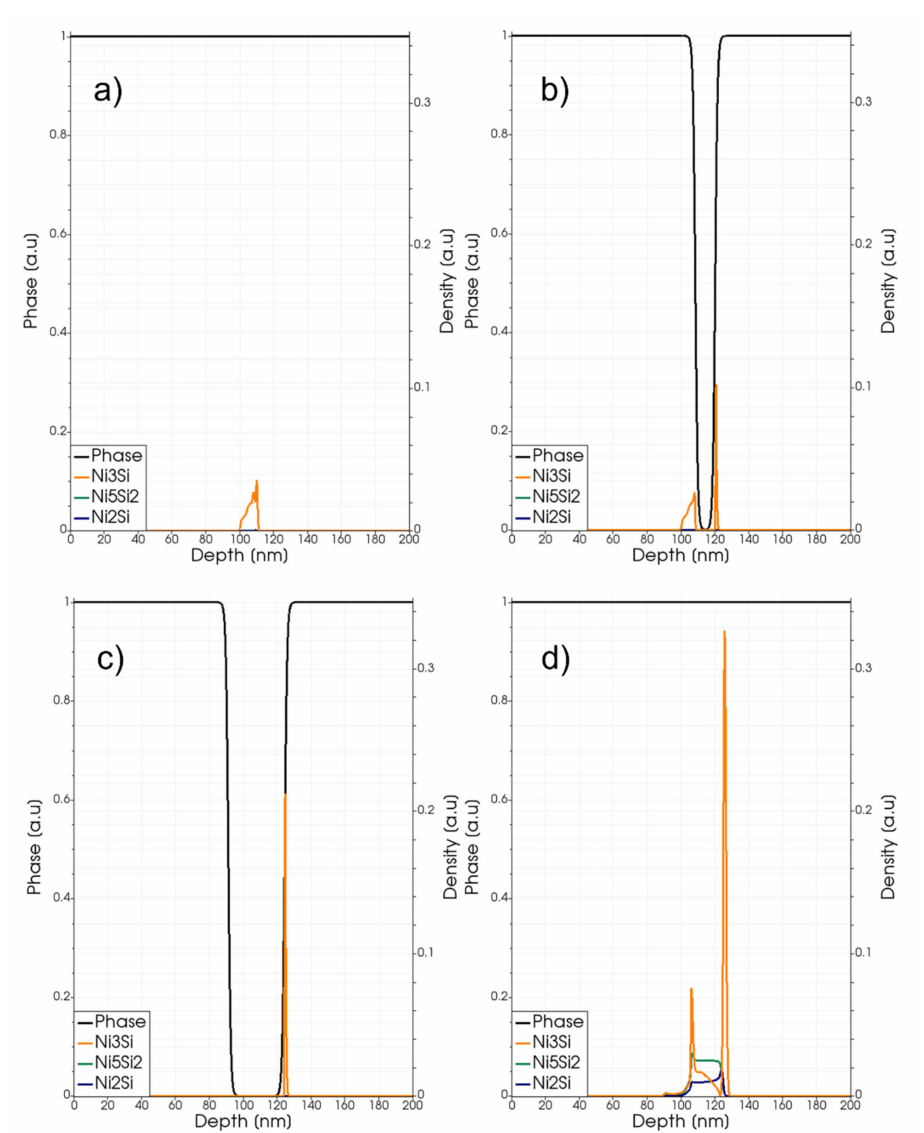
Figure 5. Phase-field (black line and left axis) and simulated local density (right axis scale) of the Ni 3 Si (dark yellow lines), Ni 5 Si 2 class (dark green lines) and Ni 2 Si (blue lines) for a laser annealing process with fluence E dens = 2.5 J/cm 2 . Snapshots ( a – d ) are taken at t = 120, 160, 200, 350